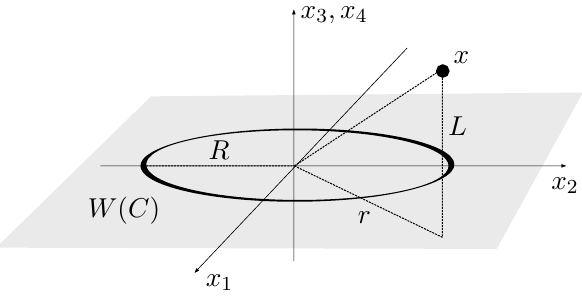
Figure 1 . The geometric set-up for the con(cid:12)guration we